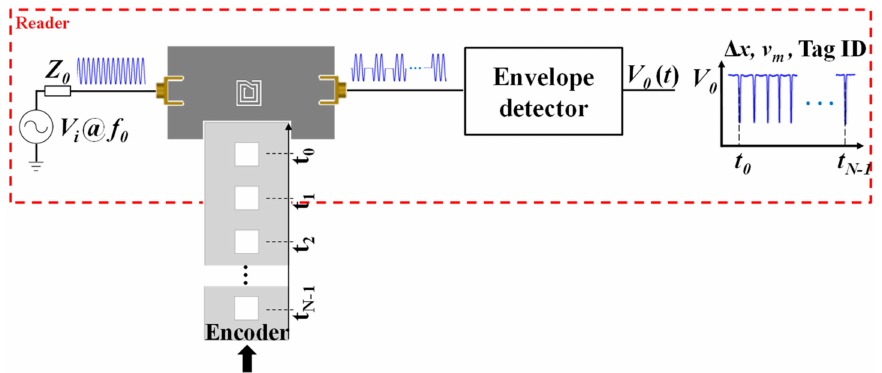
Figure 13. Sketch of the working principle of the all-dielectric electromagnetic encoders based on permittivity contrast. Figure extracted from [53].